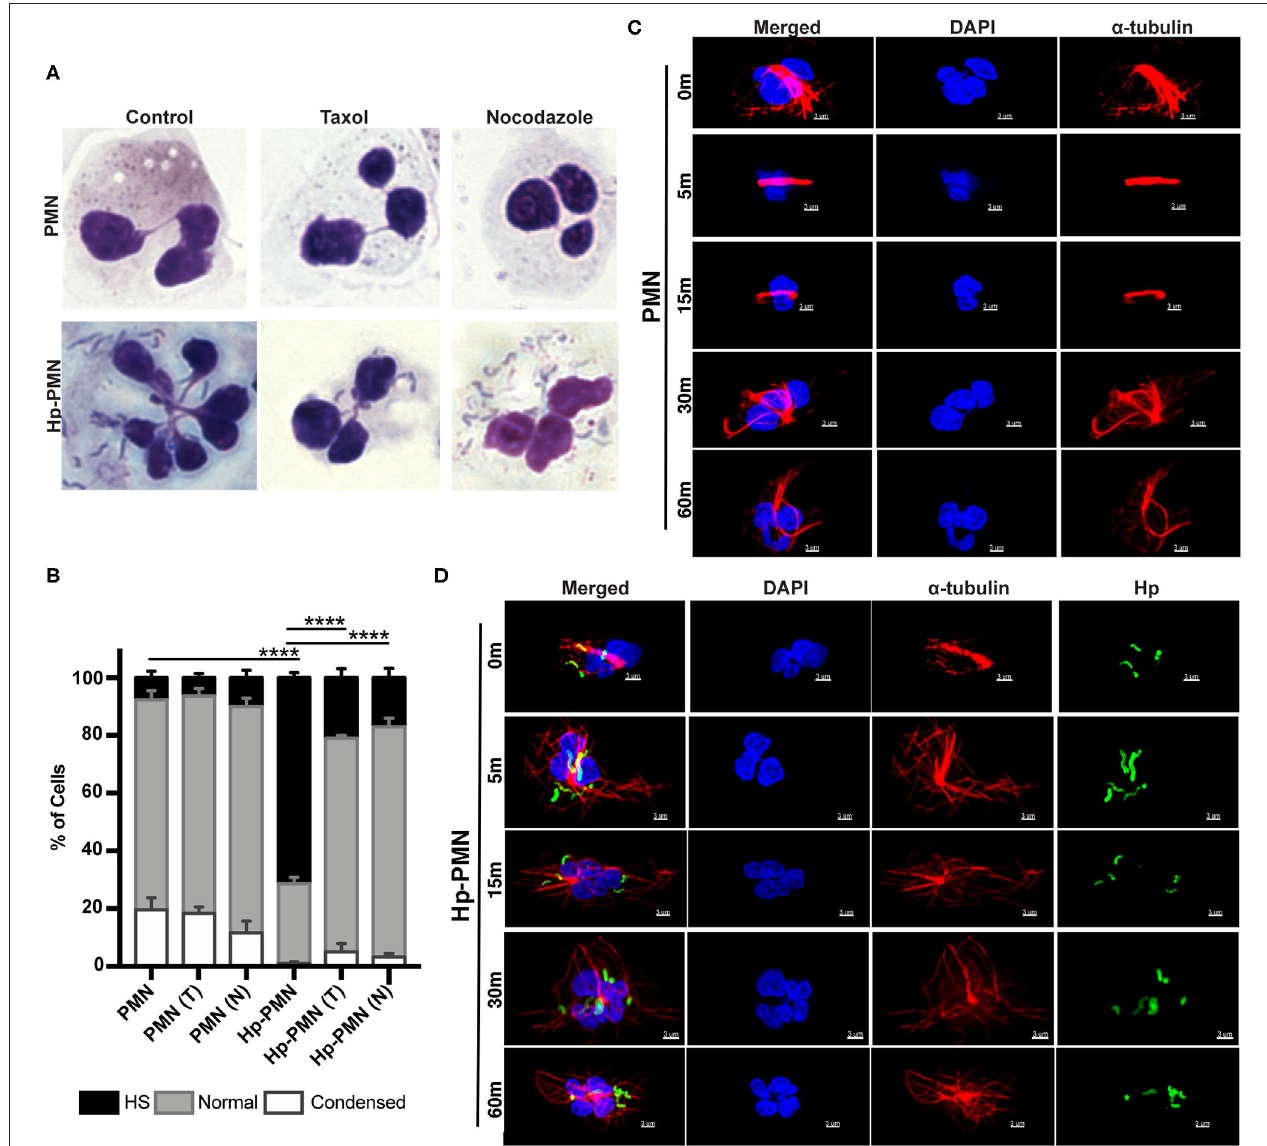
FIGURE 4 | MT dynamics are required to sustain H. pylori -induced hypersegmentation. (A,B) Infected and uninfected PMNs were treated with taxol (T) or nocodazole (N) at 18h. Representative images of Hema-3-stained cells are shown in (A) and pooled data are shown in (B) . Nuclei were scored as hypersegmented (HS), normal or condensed as in Figure 1 . Graph shows the mean + standard error of the mean, n = 3. Significant differences in hypersegmentation were detected using two-way ANOVA and Tukey’s multiple comparison test. **** P ≤ 0.0001. (C,D ) PMNs were treated with taxol in the presence and absence H. pylori at time zero. Taxol was removed at 18h and the kinetics of MT rearrangement over 5-60min at 37 ◦ C was analyzed using confocal microscopy. Representative images of uninfected PMNs (C) and infected PMNs (D) that were stained to detect DNA (DAPI, blue) and α -tubulin (Alexa Fluor 549, red) alone or together with H. pylori (Alexa Fluor 488, green), n = 3. Scale bar = 3 µ m (x1,000 original